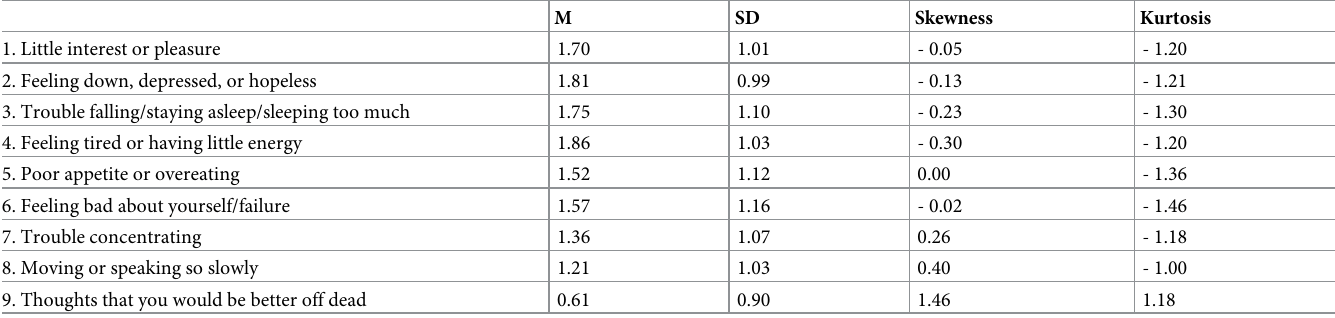
Table 2. Descriptive statistics of the PHQ-9